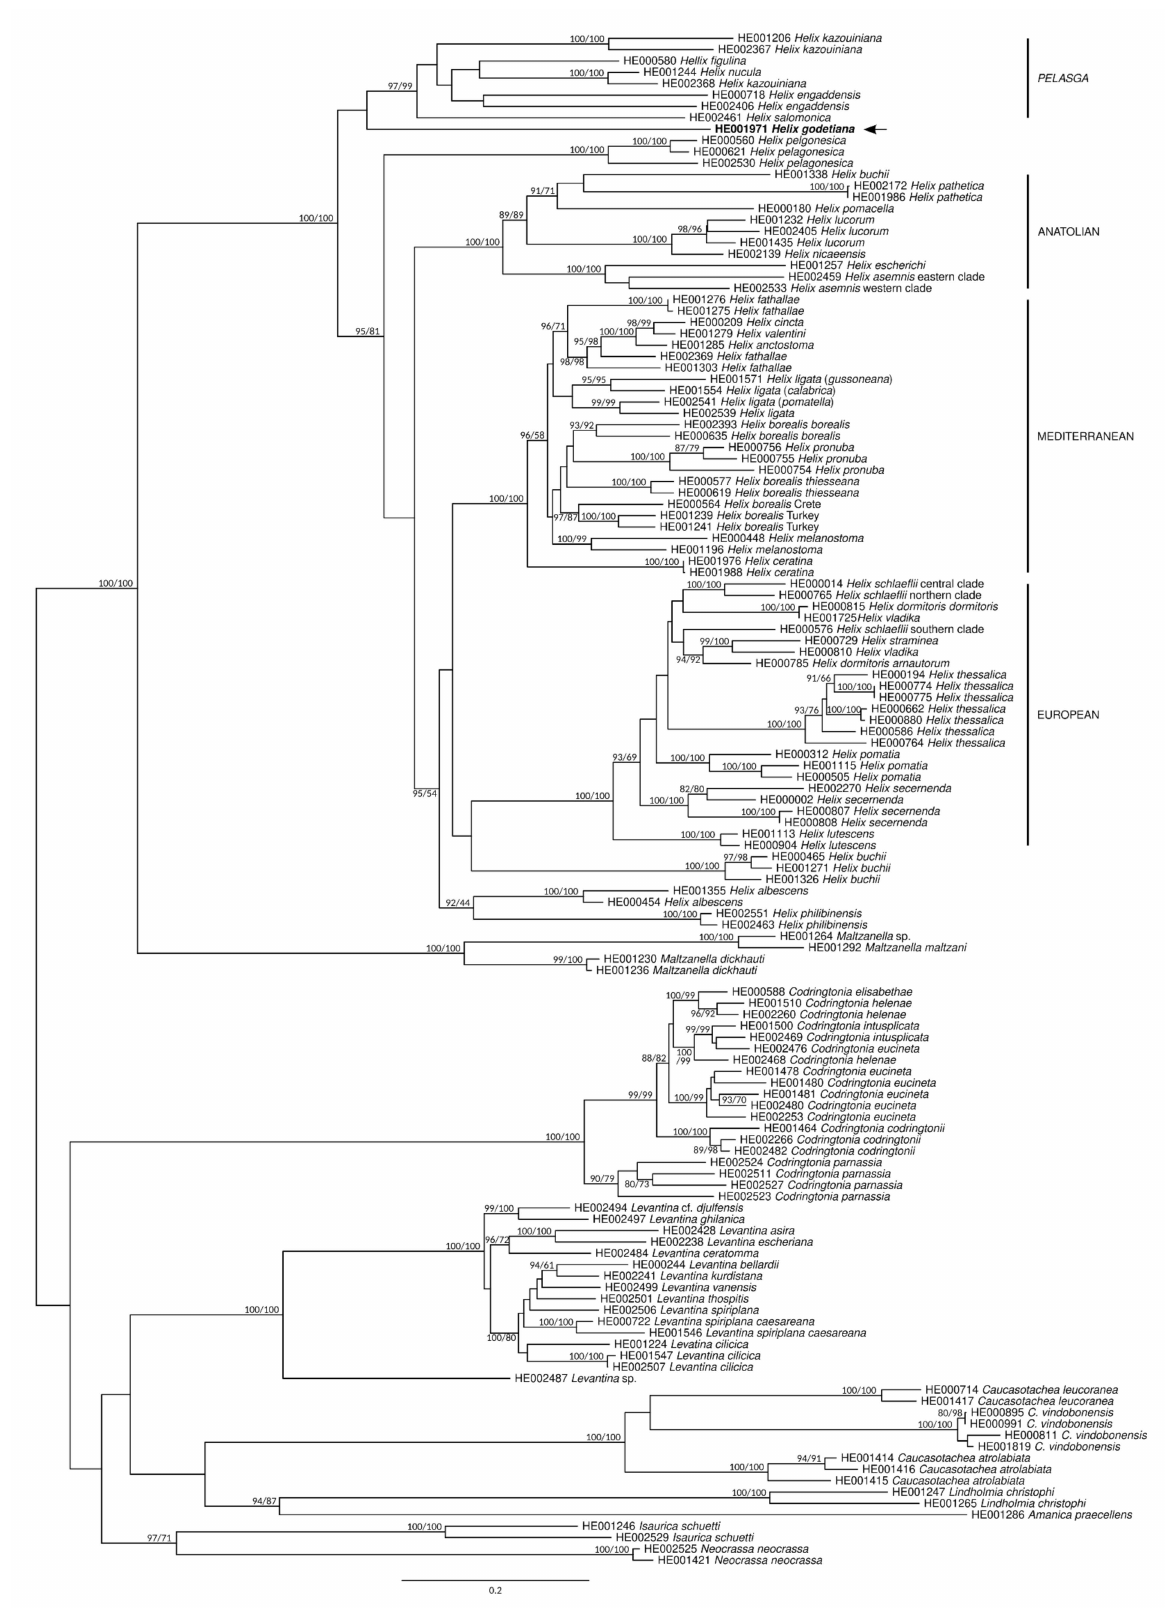
Figure 3. Unrooted maximum likelihood phylogeny of Helicini, based on concatenated cox1 , cytb , cox2 , 16S and 12S sequences. Support values are given as SH-aLRT/bootstrap percentages, support is shown only for branches with SH-aLRT value >90 or bootstrap >70% is shown. The position of Helix godetiana is marked with an arrow and major clades within Helix , discussed in the text, are